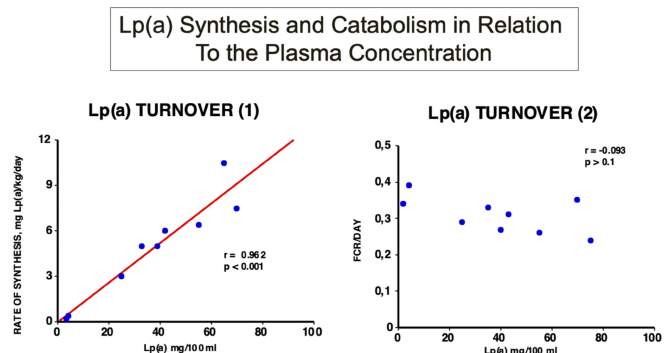
Figure 4. Turnover studies of Lp(a) in humans: Labelled and purified Lp(a) was injected into nine healthy probands with Lp(a) concentrations ranging from 5–84 mg/dL, and the decay over time was followed. As can be seen, the rate of Lp(a) biosynthesis, and not the fractional catabolic rate, correlates significantly with the plasma concentration